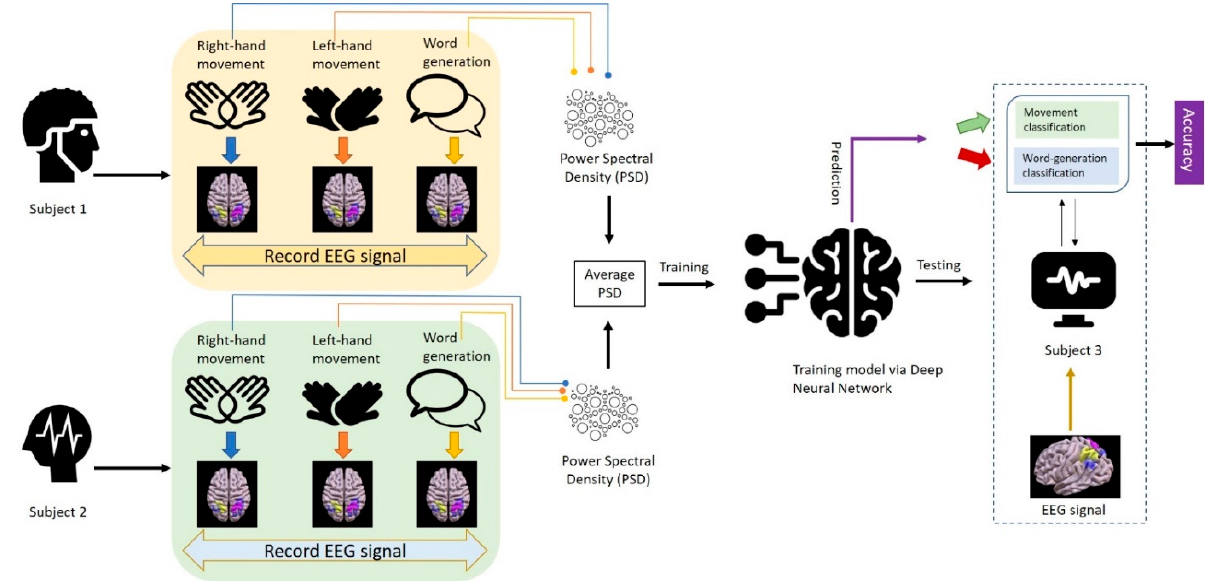
Figure 3. Flowchart for the proposed model.